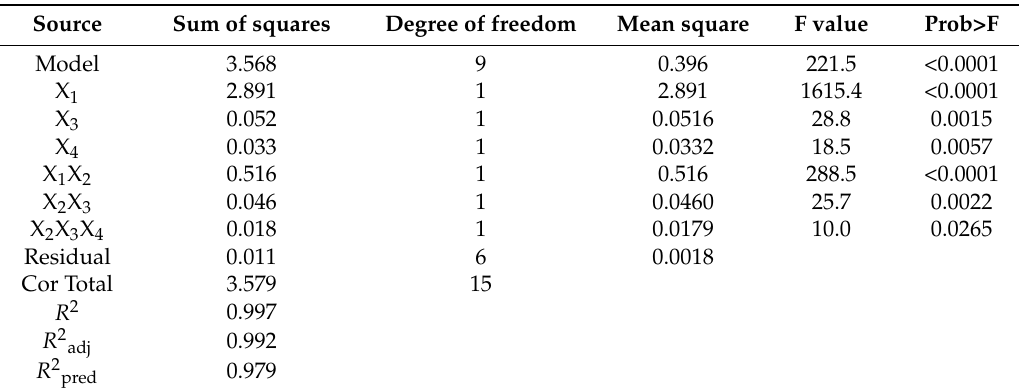
Table 3. Statistical result of ANOVA for reduced model of response variable “ K